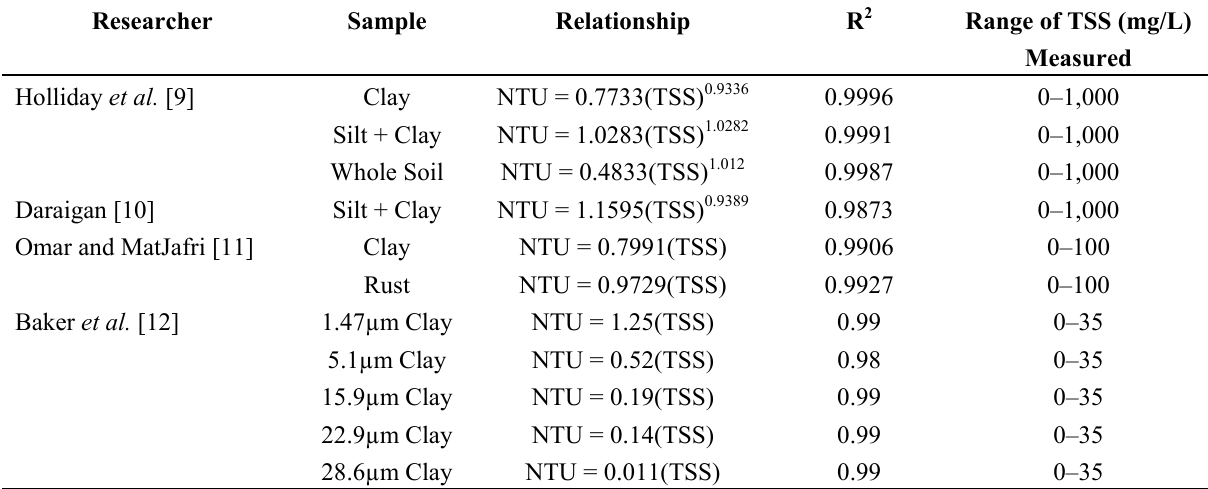
Table 1. Relationship between Turbidity and TSS conducted by four researchers